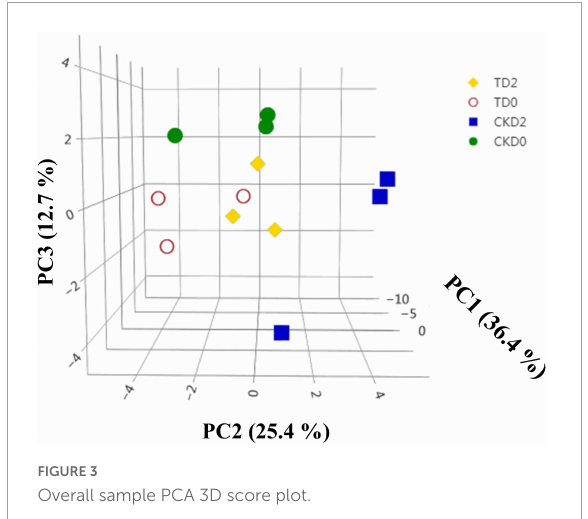
FIGURE3 Overall sample PCA 3D score